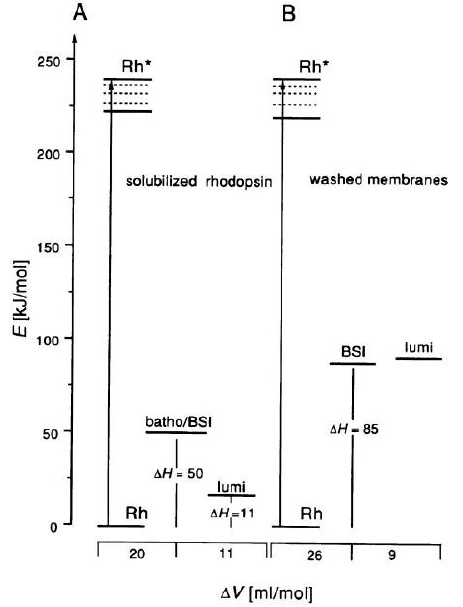
Figure 9. Energy levels of the intermediates and the structural volume changes for the photoinduced transformation of rhodopsins (reproduced with permission from Elsevier